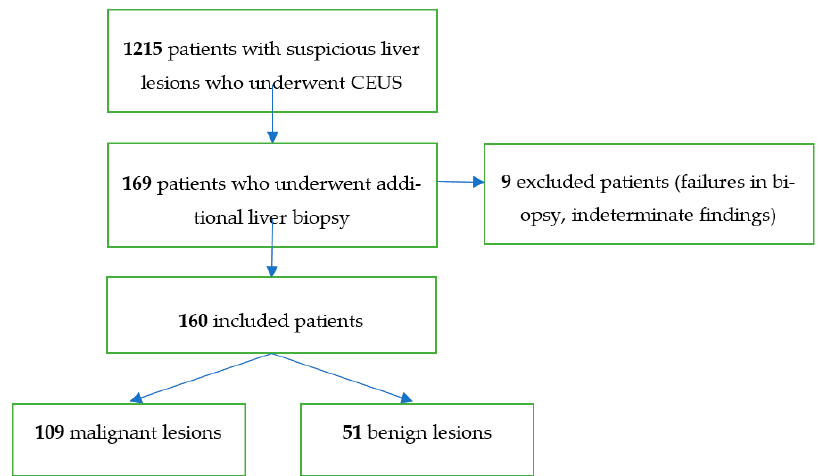
Figure 1. Flowchart illustrating the included patients who underwent CEUS followed by liver biopsy.